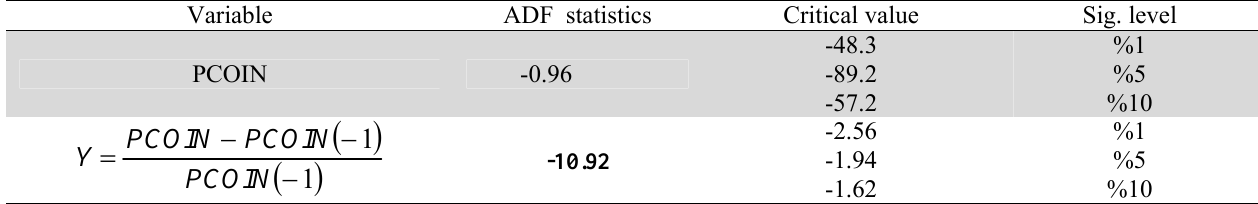
The summary of Dickey Fuller test